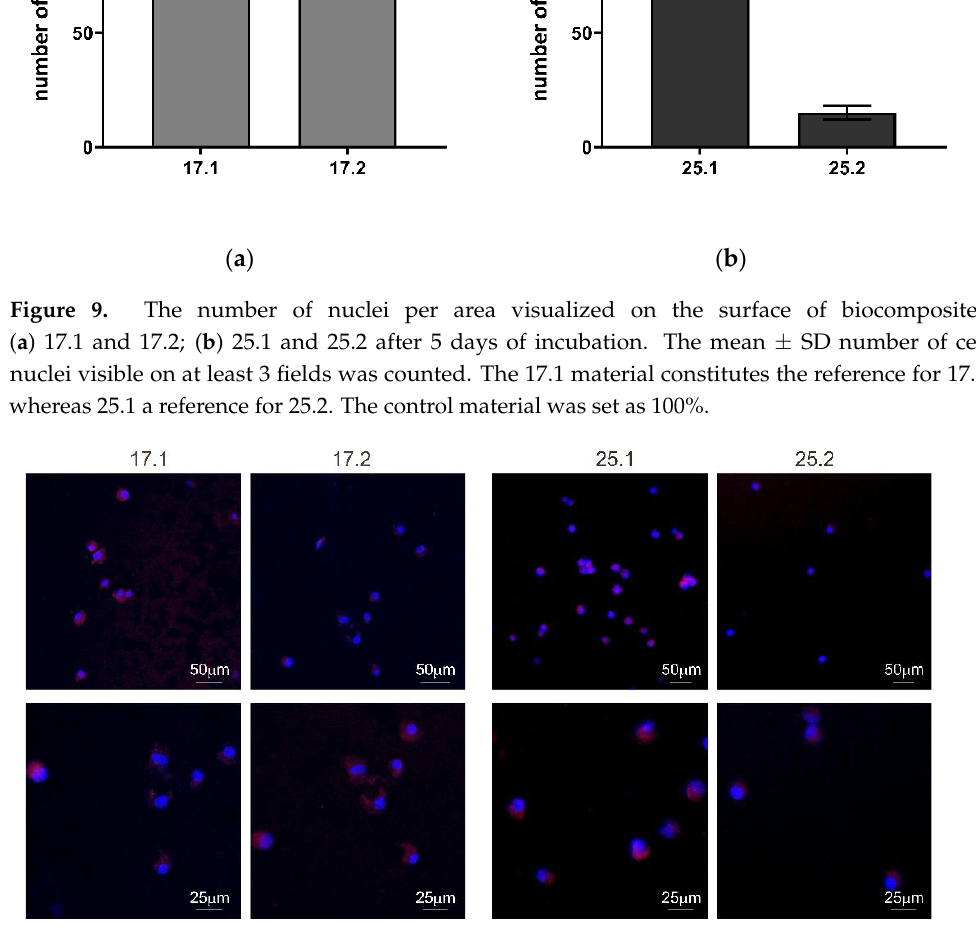
Figure 10. Visualization of L929 cells adhesion and expansion on the surface of biocomposites (17.1, 17.2, 25.1 and 25.2) after 5 days. The nuclei were stained with 300 nM 2-(4-amidinophenyl)-1H-indole-6-carboxamidine (DAPI) and actin filaments with phalloidin conjugated with iFluor 594. Samples were imaged with the following wavelength values of excitation and emission: 405 and 430–480 nm for DAPI, 590 and 615–630 nm for iFluor 594 conjugated antibody. Leica Application Suite X (LAS X; Leica Microsystems) was used for cell imaging.